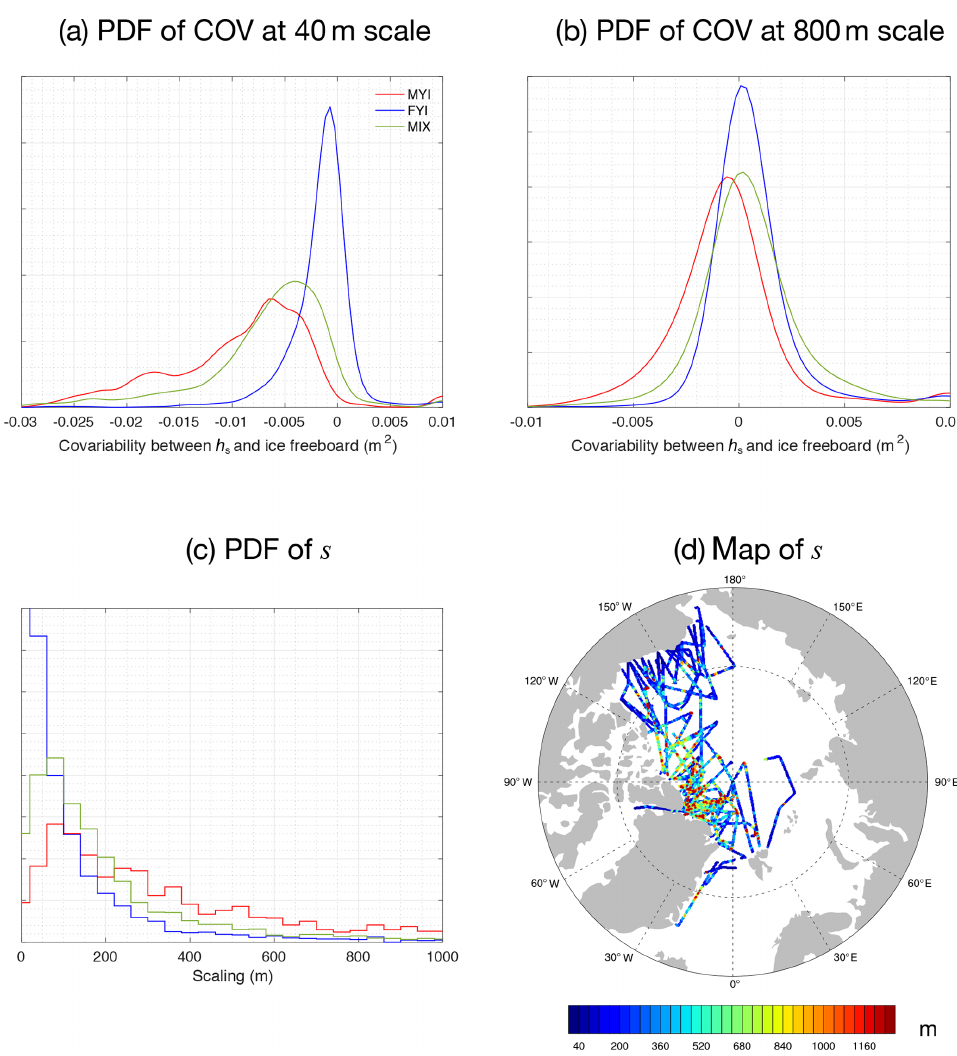
Figure 7. Covariability between F i and h s on 40m (a) and 800m (b) scale. Distribution of sample-estimated covariance between h s and F i is shown (with correction for (cid:15) SR ). Critical spatial scale ( s ) for negative covariability between h s and F i is shown in (c) (PDF) and (d)